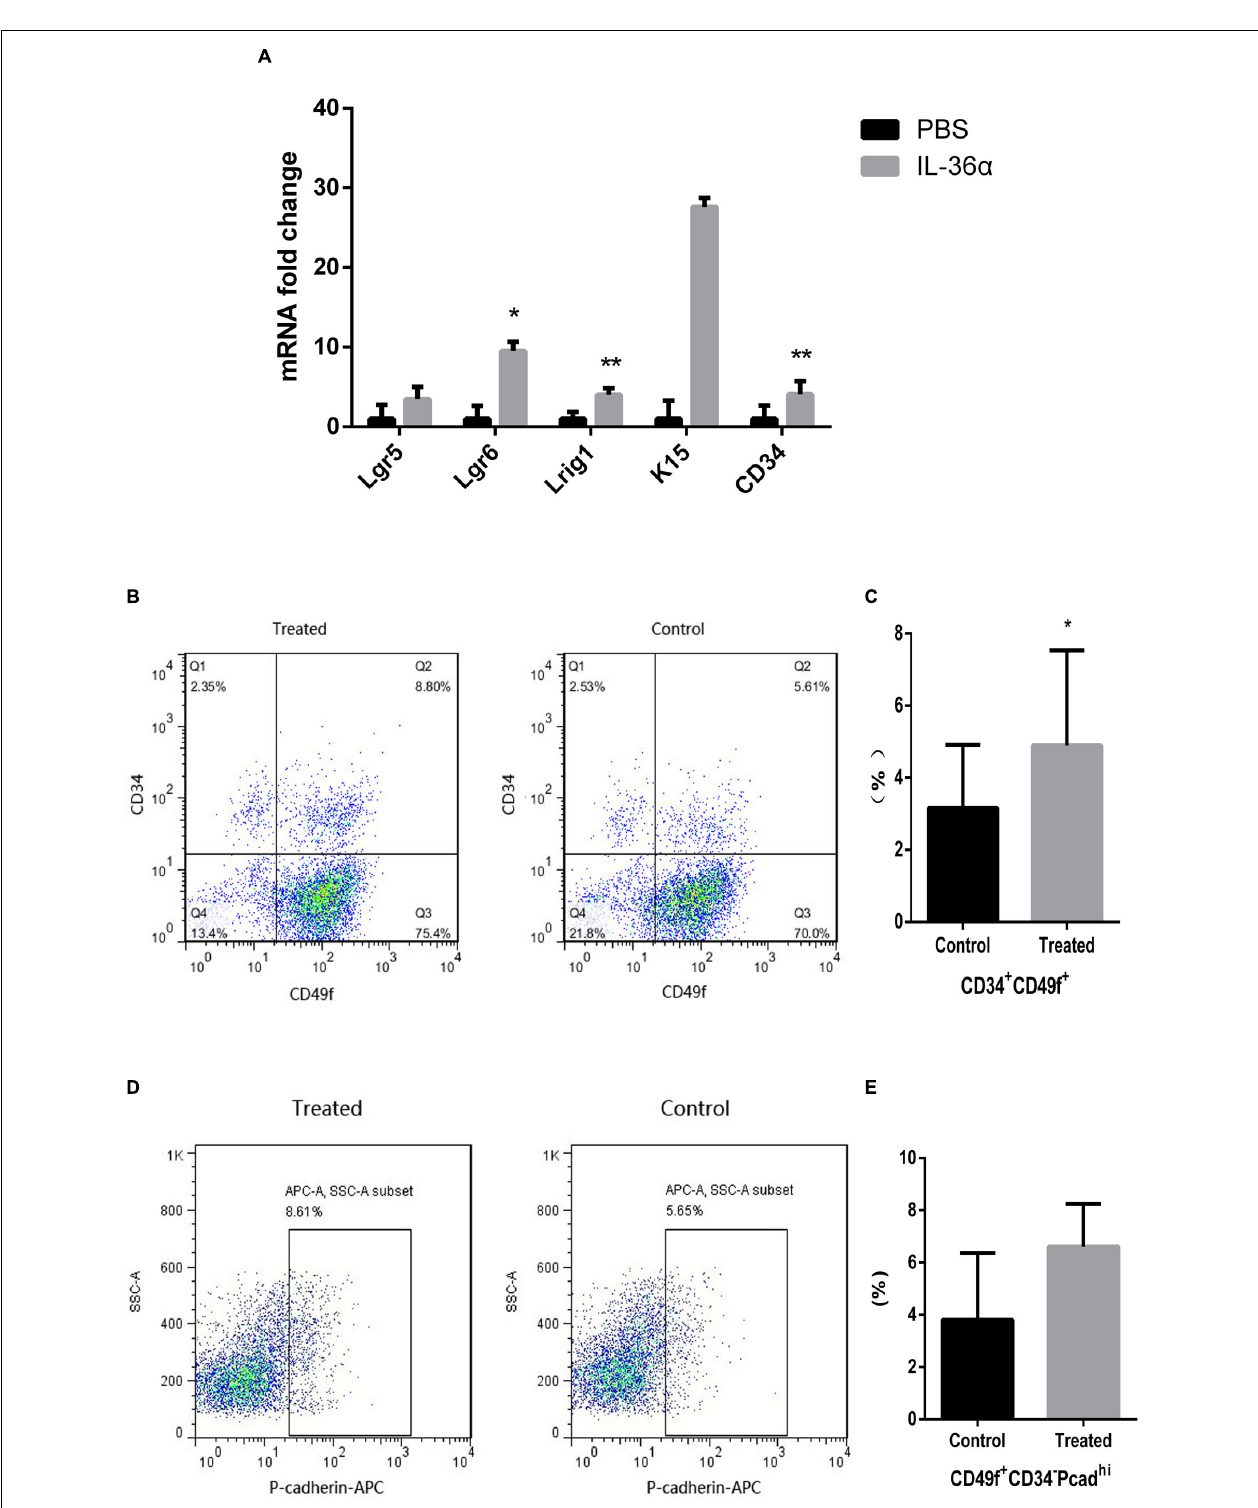
FIGURE 4 | IL-36 α causes an increase in the expression of hair follicle stem/progenitor cell markers in mice skin. A total of 50 µ L of 1 ng/ µ L mrIL-36 α dissolved in PBS or PBS only was injected intradermally into two separate dorsal regions of skin of 7-week-old mice for 3 days. (A) The relative mRNA expression levels of hair follicle stem/progenitor cell markers ( Lgr5, Lgr6, Lrig1, K15, and CD34 ) in mrIL-36 α -injected region and control region were evaluated using real time quantitative PCR ( n = 4). Total epithelial cells were subjected to flow cytometry analysis after staining for CD34, CD49f and Pcad. Flow cytometry analysis of hair follicle stem/progenitor cells marked by CD34 + CD49f + (B,C) and CD34 - CD49f + Pcad hi (D,E) (* p < 0.05, ** p < 0.005, n = 4).